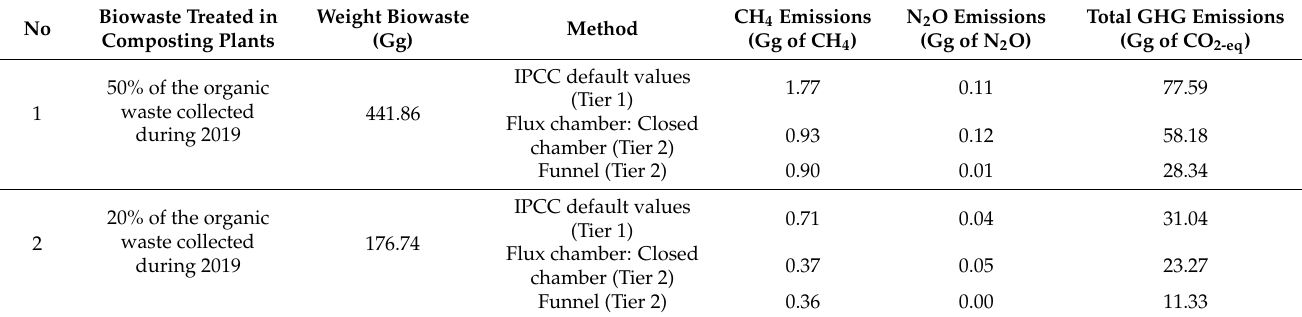
Figure 1. FOD method for solid waste disposal sites in Bolivia (self-elaboration). Table 4. GHG emissions in open windrow composting plants of Bolivia